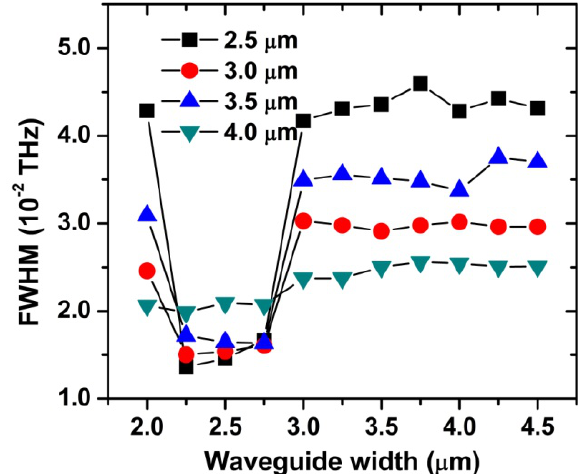
Figure 8. Effect of the waveguide width on FWHM (d = 100 μ m, g = 0 μ